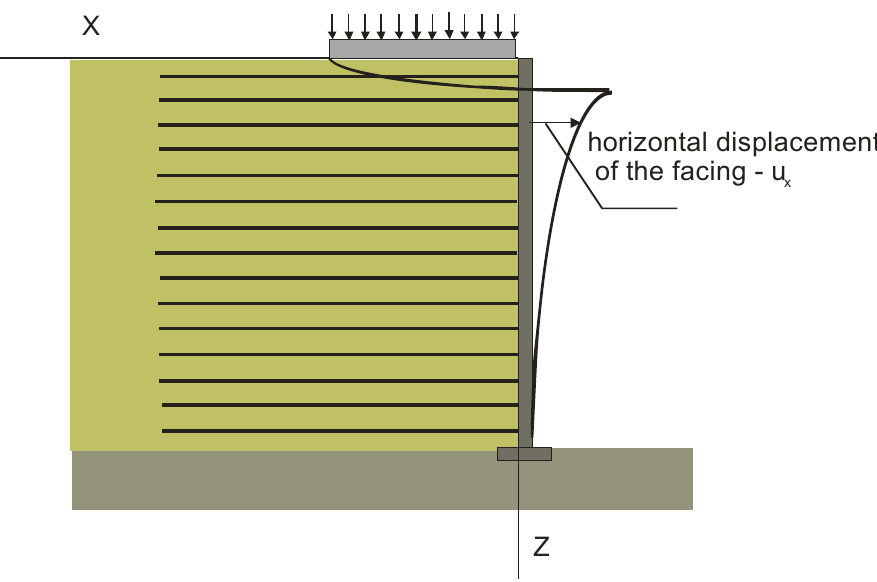
Figure 1. Deformations of RS structure under serviceable loading.